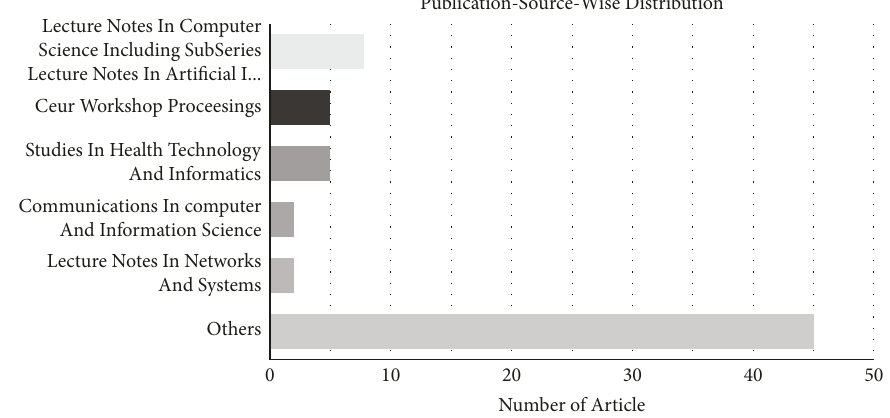
Figure 4: Publication-source-wise distribution.